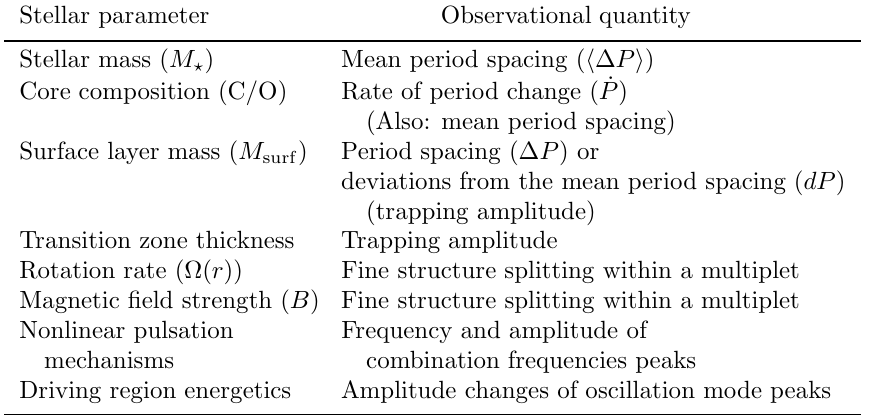
Table 1. Asteroseismological parameters. Stellar